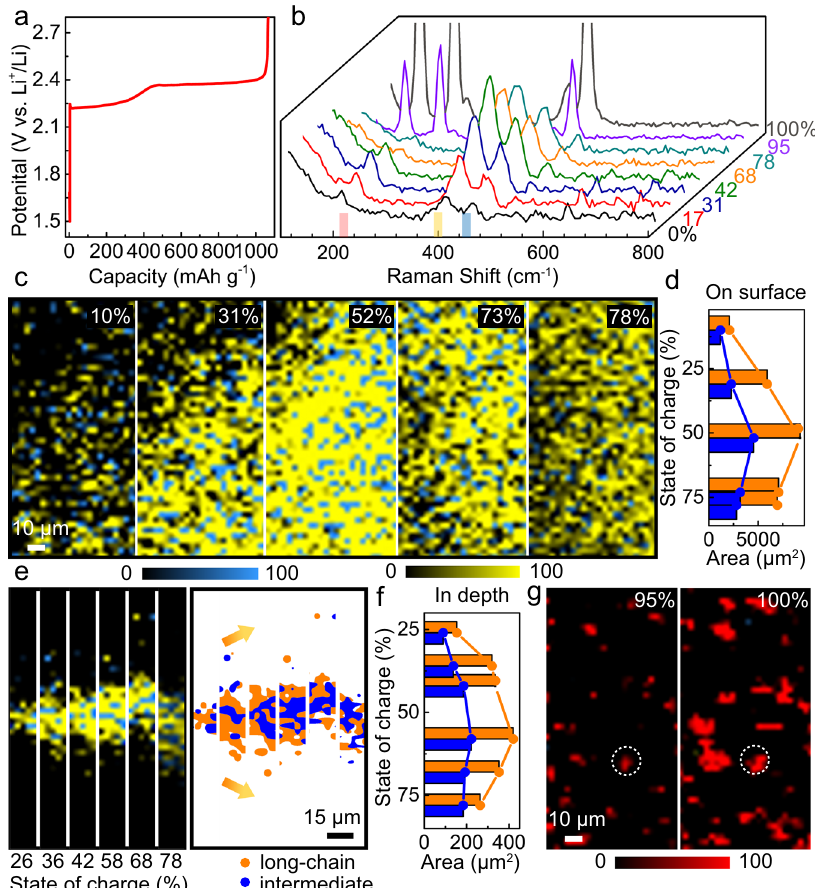
Fig.5| Operando confocalRamaninvestigationofLi – Sredoxprocessesduring thegalvanostaticchargeprocessintheinitialcycle.a Voltagepro fi le, operando Raman ( b ) spectra, c on surface mapping and e in depth (Z-direction) mapping imagesofpolysul fi desduringdifferentSOCsatarateof0.02C(1C=1672mAhg − 1 ). Right side of e : color mapping changes of the in depth (Z-direction) mapping images. d , f quanti fi eddataofpolysul fi deevolutionanddiffusiononsurfaceandin